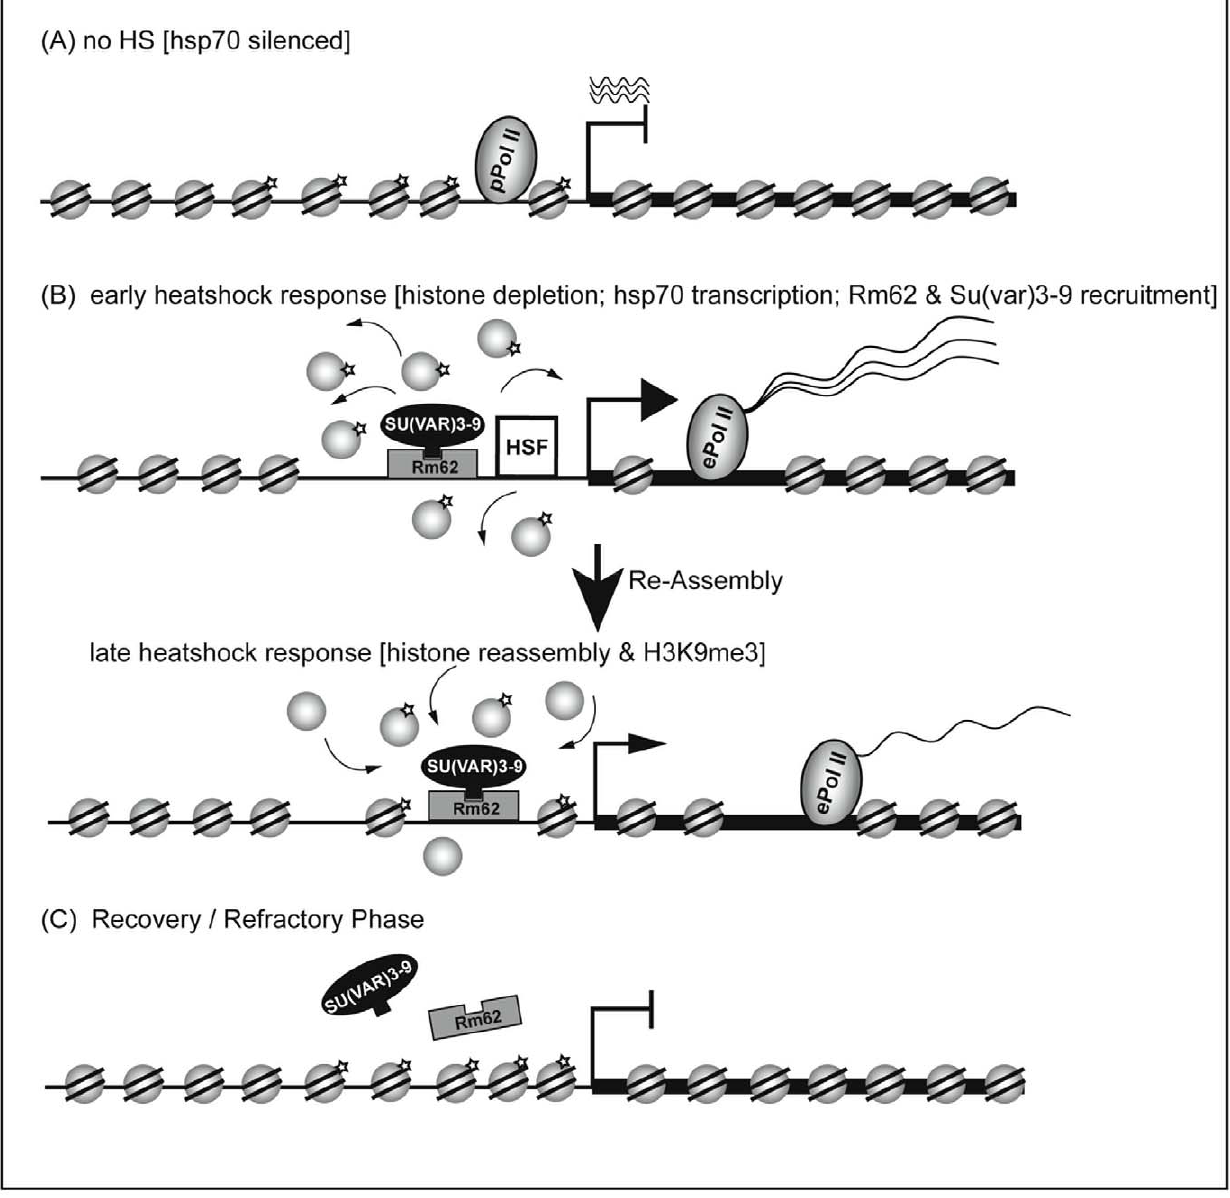
Figure 7. Model for SU(VAR)3-9/Rm62 action at the hsp70 -locus. ( A ) Under non-heat shock conditions the hsp70 gene is silenced, but a paused PolII (pPolII) is bound to the promoter and small, kryptic RNAs originate from the transcription start site. ( B ) Early heat shock response: upon heat shock, heat shock factor 1 (HSF) is recruited to the hsp70 promoter, resulting in PolII promoter release and conversion of paused to elongating Pol II (ePolII), leading to the massive generation of hsp70 RNA. On the chromatin level this state is characterised by histone methylation (H3K4) and subsequent histone depletion. We find that the heat shock also leads to a recruitment of Rm62 and SU(VAR)3-9 to the hsp70 locus in a RM62 dependent manner. Late heat shock response: when the heat shock trigger ceases, reassembling histones get methylated by SU(VAR)3-9 that is already bound. As a consequence of chromatin reassembly, transcription re-initiation and hsp70- RNA production are strongly diminished. ( C ) The chromatin state in the recovery or refractory phase is characterised by a high level of H3K9 methylation and a complete silencing of hsp70 transcription. SU(VAR)3-9 and Rm62 are released and the gene locus which is prone for another activation cycle.